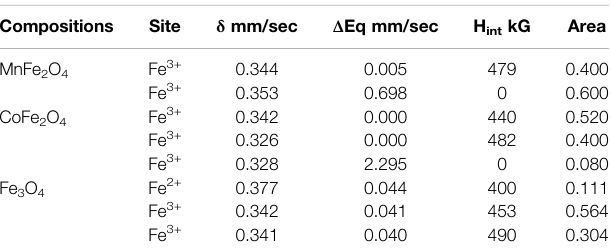
TABLE 3 | Hyper fi ne parameters, isomer Shift ( δ ), quadruple splitting ( Δ E q ), internal hyper fi ne magnetic fi eld (H int ), and area under the curve of subspecies from the model fi tting of experimental data of Mössbauer spectroscopy for